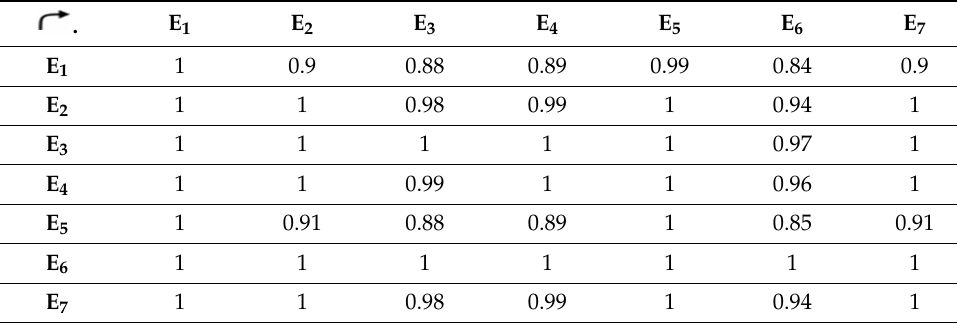
Table 9. Effects–effects estimation matrix [ (cid:101) B ]